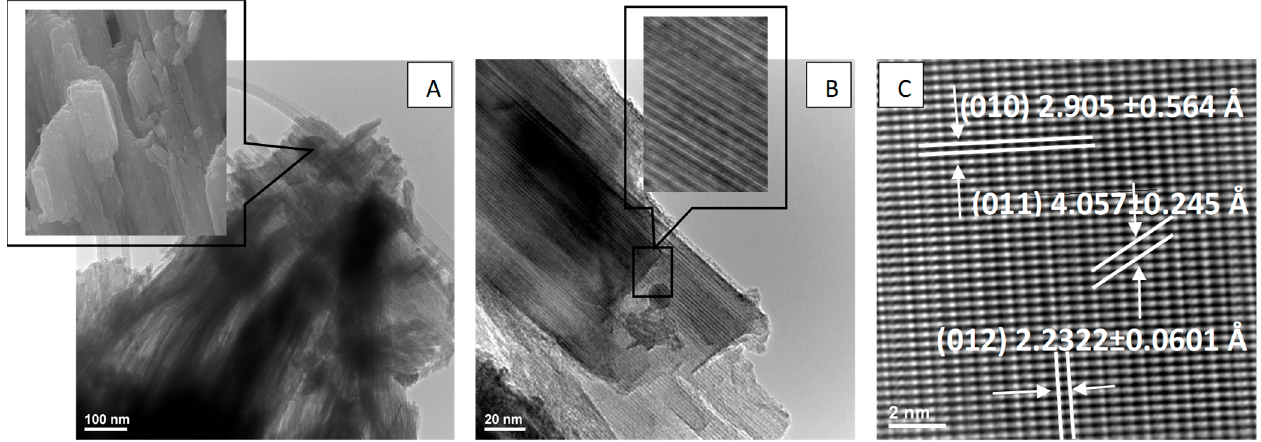
Figure 12. TEM ( A , B ) and HRTEM ( C ) images for particles of the sample K8N2_200_30.